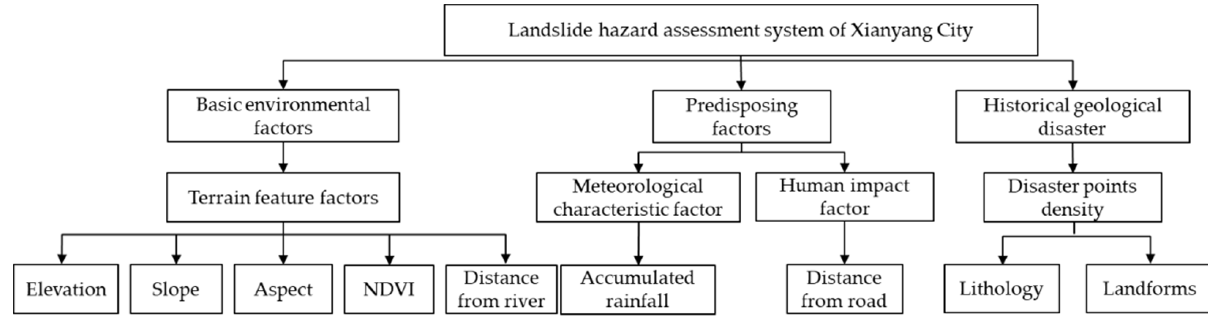
Figure 2. The landslide hazard evaluation index system.